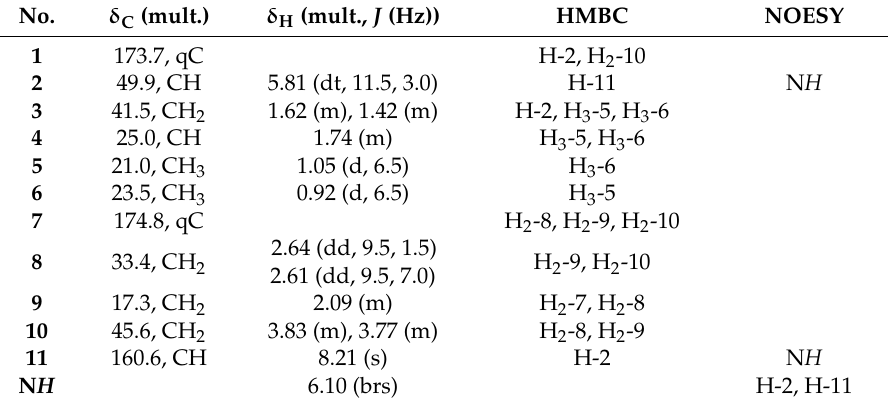
Table 1. NMR data of compound 1 (CDCl 3 , 850 and 213 MHz).